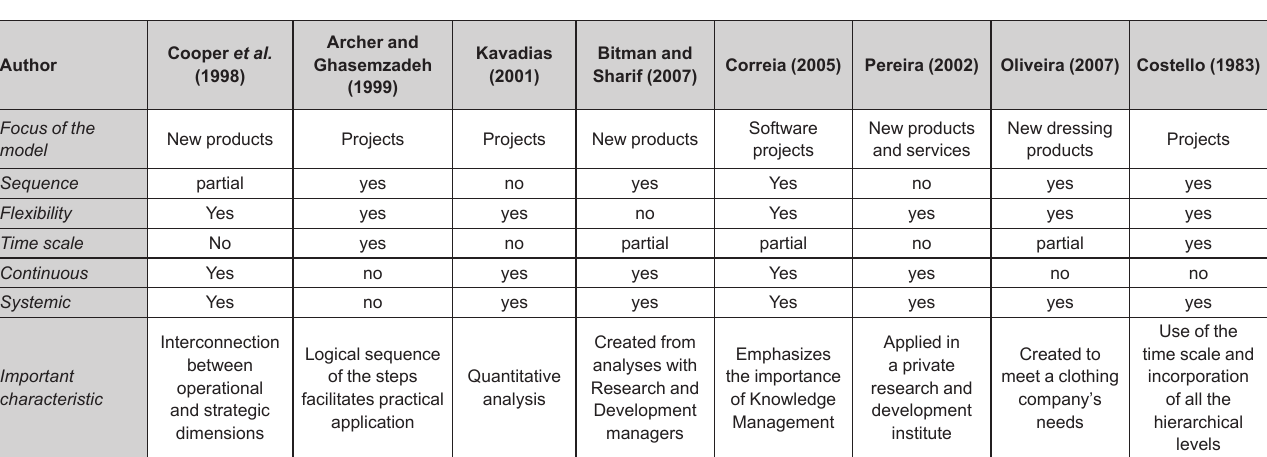
FIGURE 1 - Portfolio Management models assessed and their